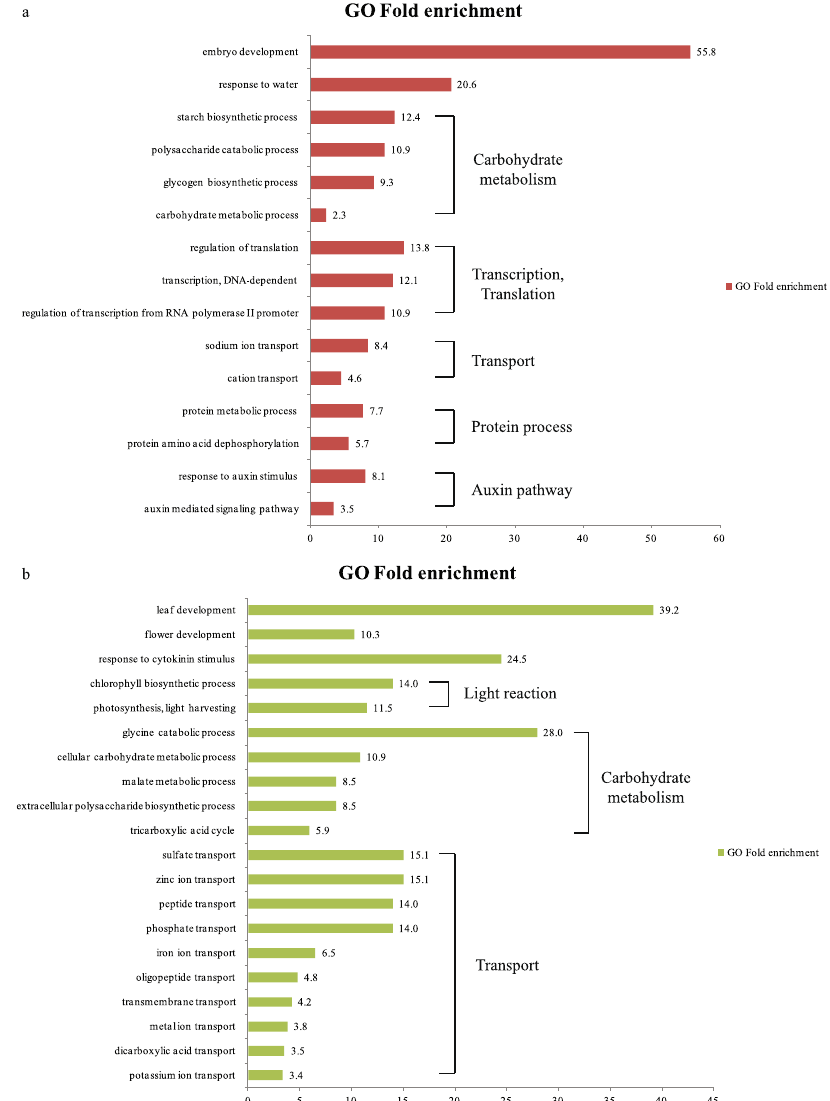
up-regulated (403; a ) or down-regulated (363; b ) by drought. Fold-enrichment values are shown along Y-axis; enriched GO terms, along